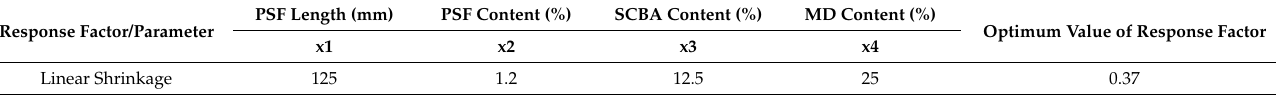
Table 6. Optimized value of the linear shrinkage for various parameters at optimized